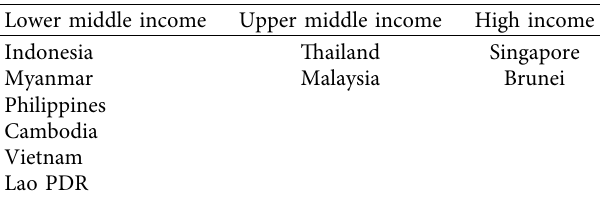
Table 1: Association of Southeast Nations (ASEAN) grouped according to the World Bank (Asian human capital index)